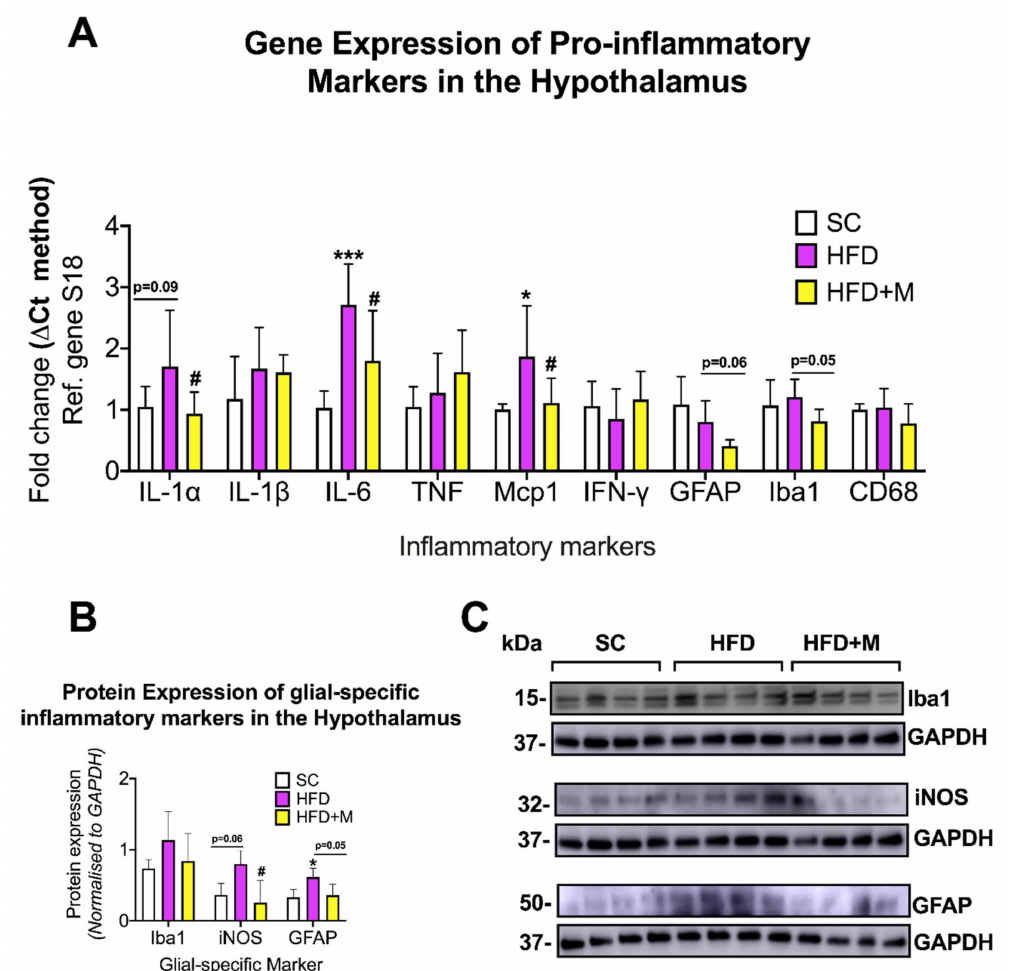
Figure 2. Gene and protein expression analysis of cytokines and glial-specific inflammatory markers in the hypothalamus of C57BL/6 mice in response to HFD or metformin administration. Mice were grouped as SC, HFD, and HFD + M. Hypothalami were microdissected from the left and right sides of the brain from all treatment groups and were used for RNA and protein extraction with subsequent quantitative qPCR and Western blotting, respectively. ( A ) Differential gene expression levels of proinflammatory mediators and glial-specific inflammatory markers. ( B ) Protein expression levels of glial-specific inflammatory marker following normalization to the loading control, GAPDH. ( C ) Immunoblot bands for each marker. mRNA levels were quantified using the ∆ Ct method and normalized to the reference gene S18 (housekeeping gene). Data were presented as mean ± S.E.M. * p < 0.05 or *** p < 0.001 vs. SC group; # p < 0.05 vs. HFD group as determined by one-Way ANOVA followed